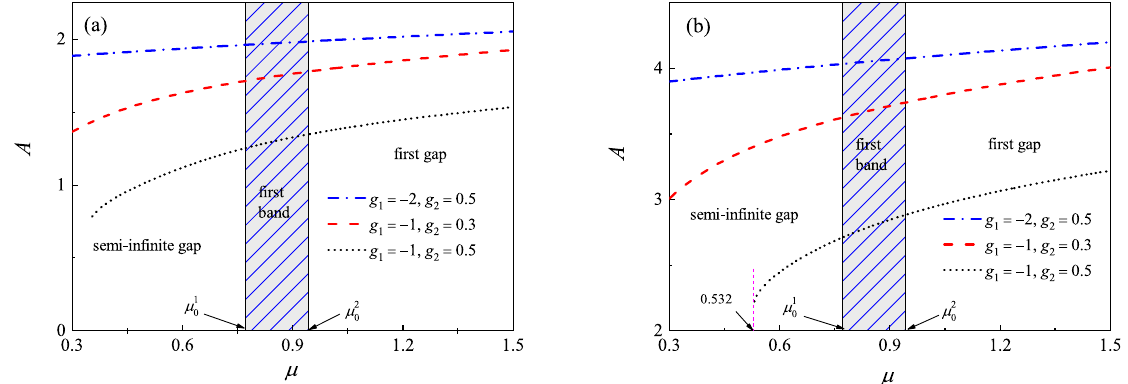
2, q 0.1 . The edge of first Bloch band is = =